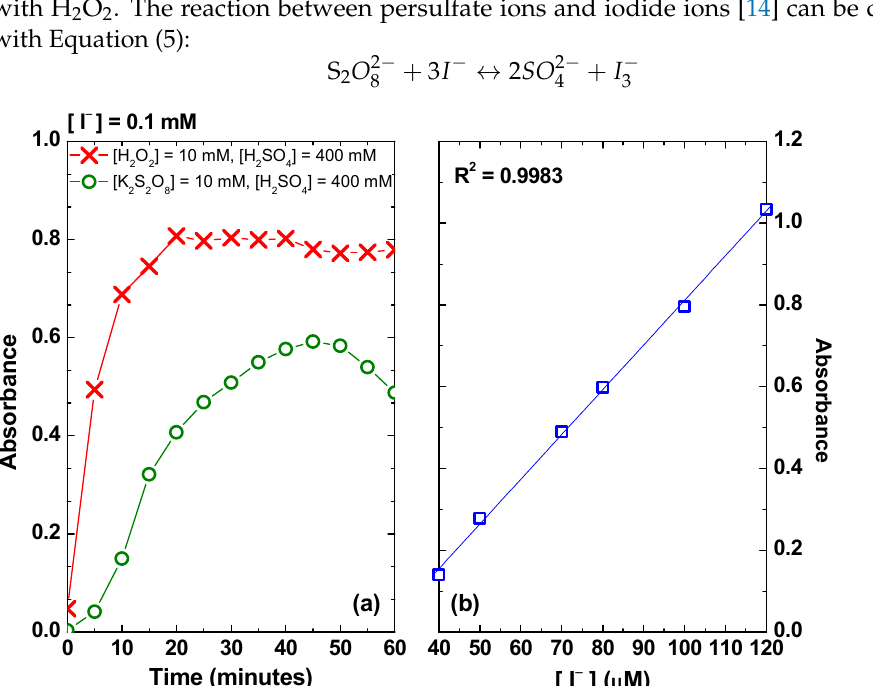
Figure 2. ( a ) UV/Vis absorbance of iodine–starch at 615 nm, prepared by using two different oxidizing agents; ( b ) the calibration curve of iodine–starch complex, synthesized under the optimized condition (i.e., [H 2 O 2 ] = 10 mM; [H 2 SO 4 ] = 400 mM; reaction time = 25–35 min).